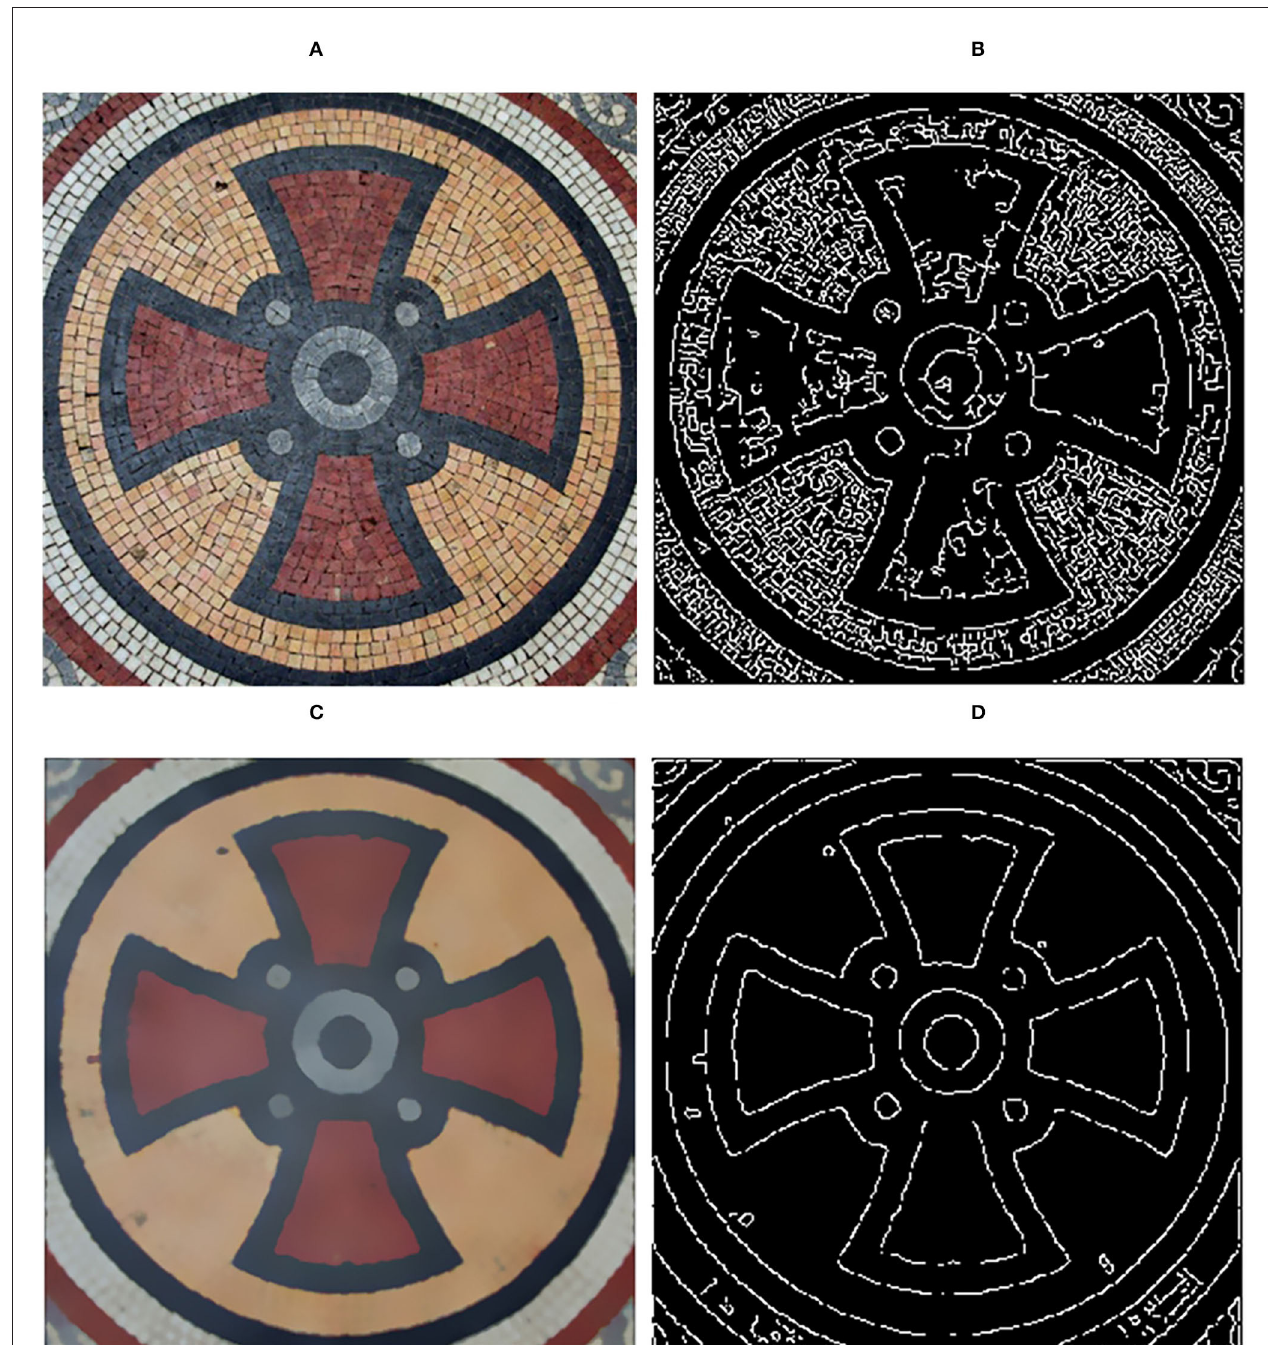
FIGURE 11 | Edge detection. (A) Input image; (B) Edge detection of input image; (C) Filtered result using our method; (D) Edge detection of filtered result. Reproduced with permission from Li Xu, Qiong Yan, Yang Xia, Jiaya Jia, available at http://www.cse.cuhk.edu.hk/%7eleojia/projects/texturesep/.